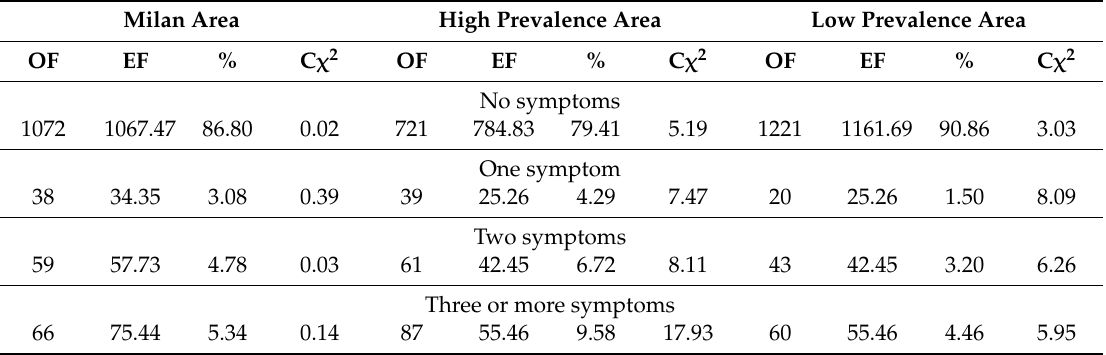
Table 3. Prevalence of symptoms / signs related to the COVID-19 in the di ff erent Lombardy provinces. Percentages were calculated per column. Milan Area High Prevalence Area Low Prevalence Area